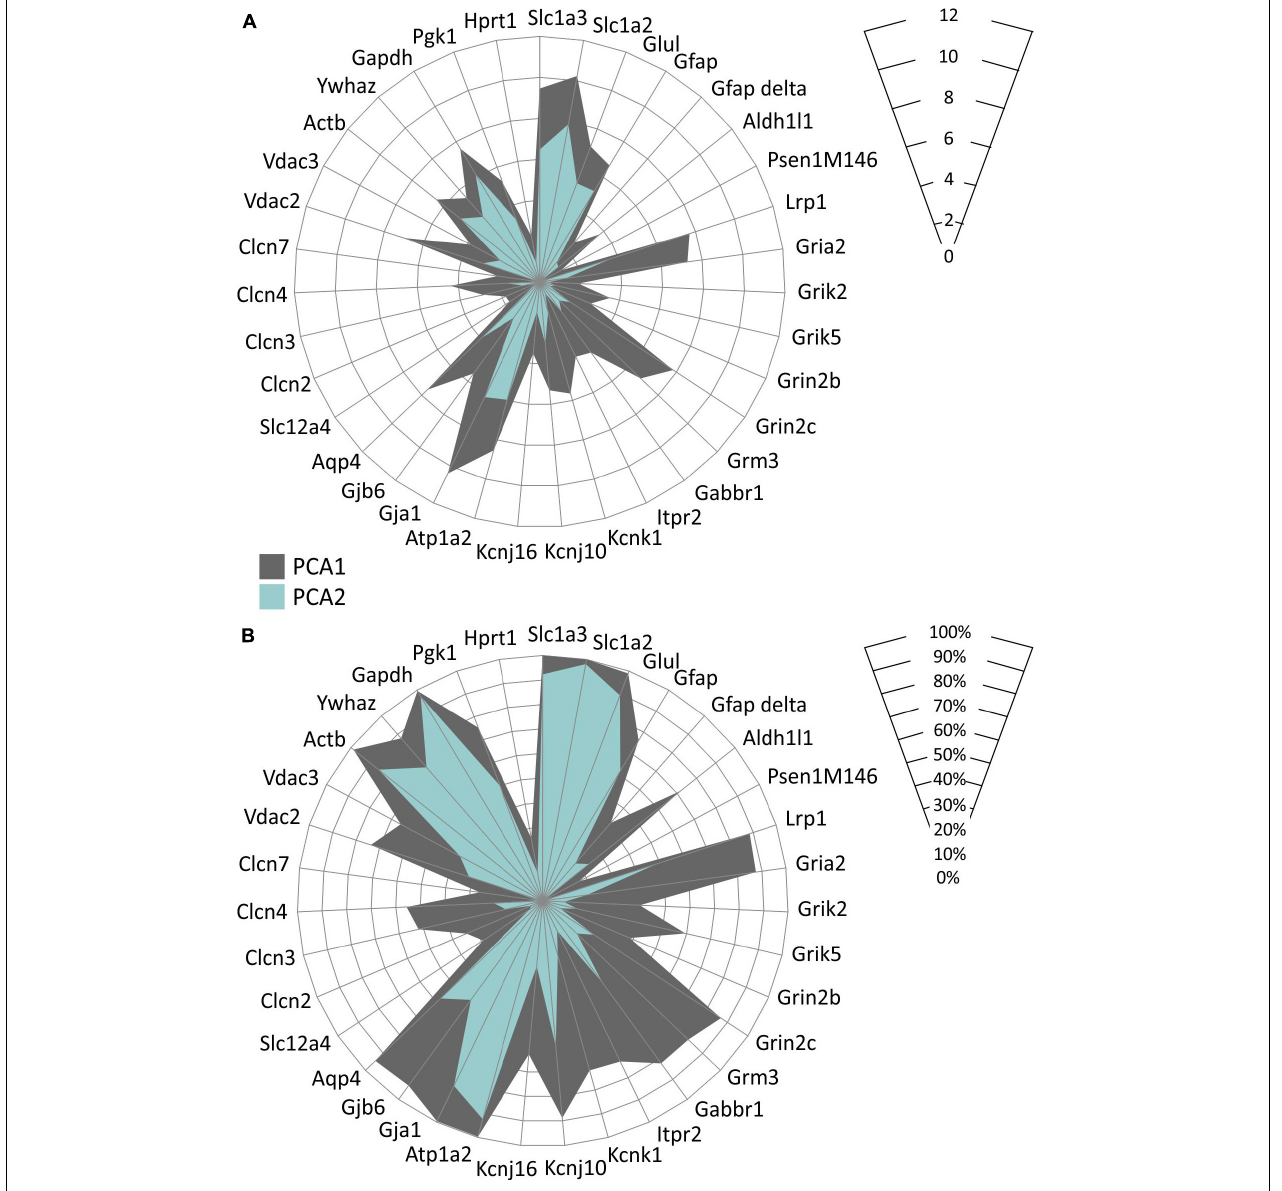
FIGURE 9 | Characterization of two EGFP-positive astrocyte subpopulations differing in the expression of the homeostatic genes identified in hippocampus of controls and 3xTg-AD mice. Subpopulations differ in levels of expression of selected genes (A) and in the percentage of cells expressing these genes (B) . Only genes, the expression of which was changed significantly ( p < 0.05) are depicted. Statistical significance was determined by two-way ANOVA test with Tukey’s post hoc